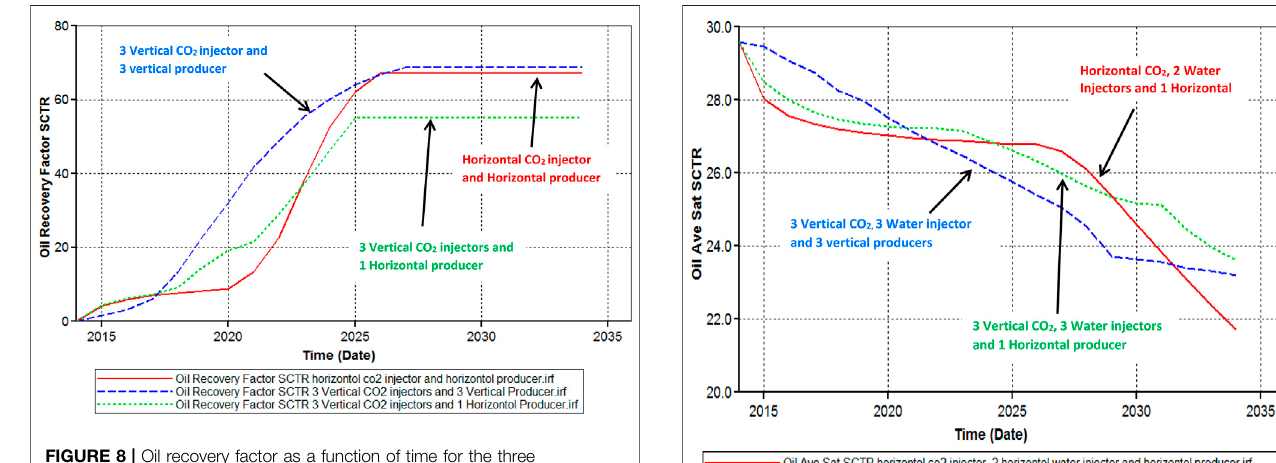
FIGURE 8 | Oil recovery factor as a function of time for the three examined cases. CO 2 was injected only into the aquifer for all cases.